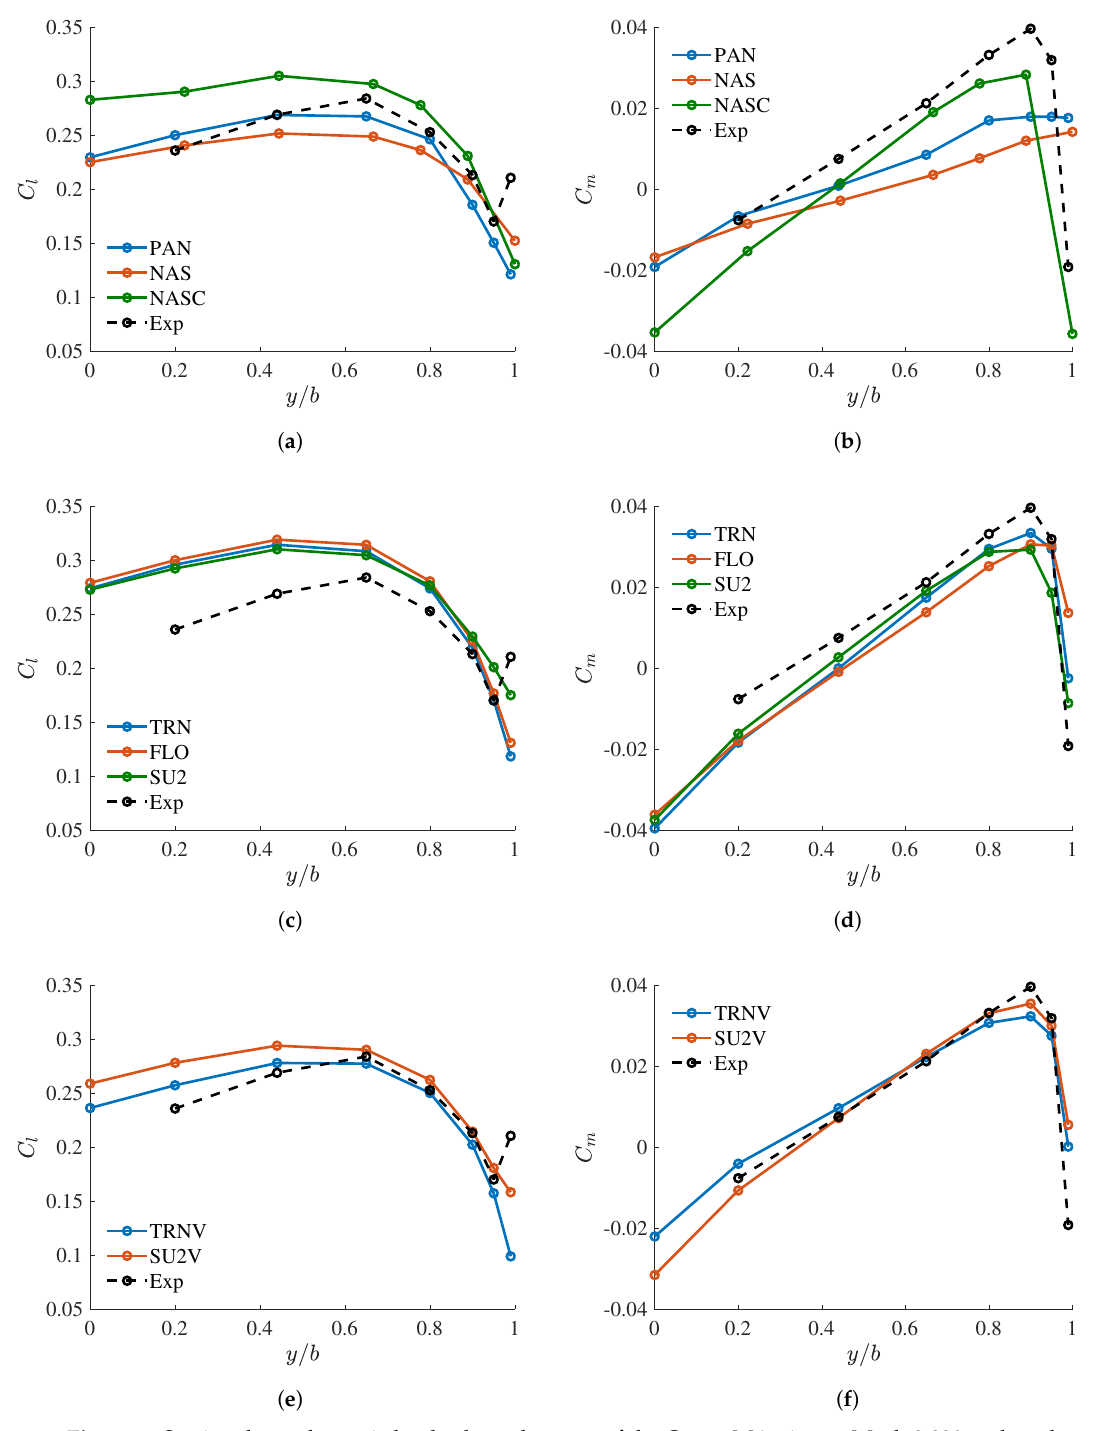
Figure 3. Sectional aerodynamic loads along the span of the Onera M6 wing at Mach 0.839 and angle of attack 3.06 ◦ obtained from different levels of fidelity and compared to experimental data [26]: ( a ) lift for linear models; ( b ) moment for linear models; ( c ) lift for nonlinear inviscid models; ( d ) moment for nonlinear inviscid models; ( e ) lift for viscous models; and ( f ) moment for viscous